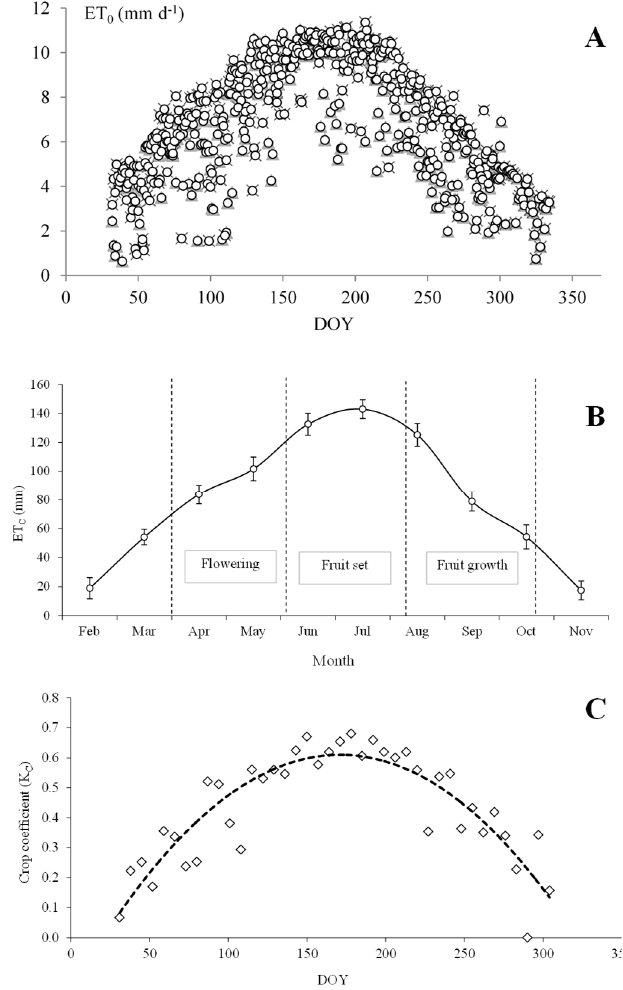
Figure 2. Average reference crop evapotranspiration ( ET 0 ) ( A ), crop evapotranspiration ( ET C ) in relation to main phenological stages ( B ), and crop coefficient as a function of day of the year (DOY) for cherimoya trees ( C ) throughout two monitoring seasons in the study zone. Bars represent the standard deviation.